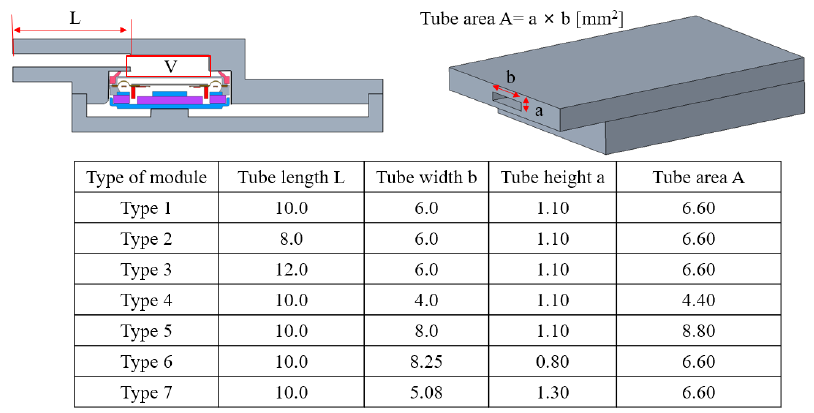
Figure 9. Different tube designs.